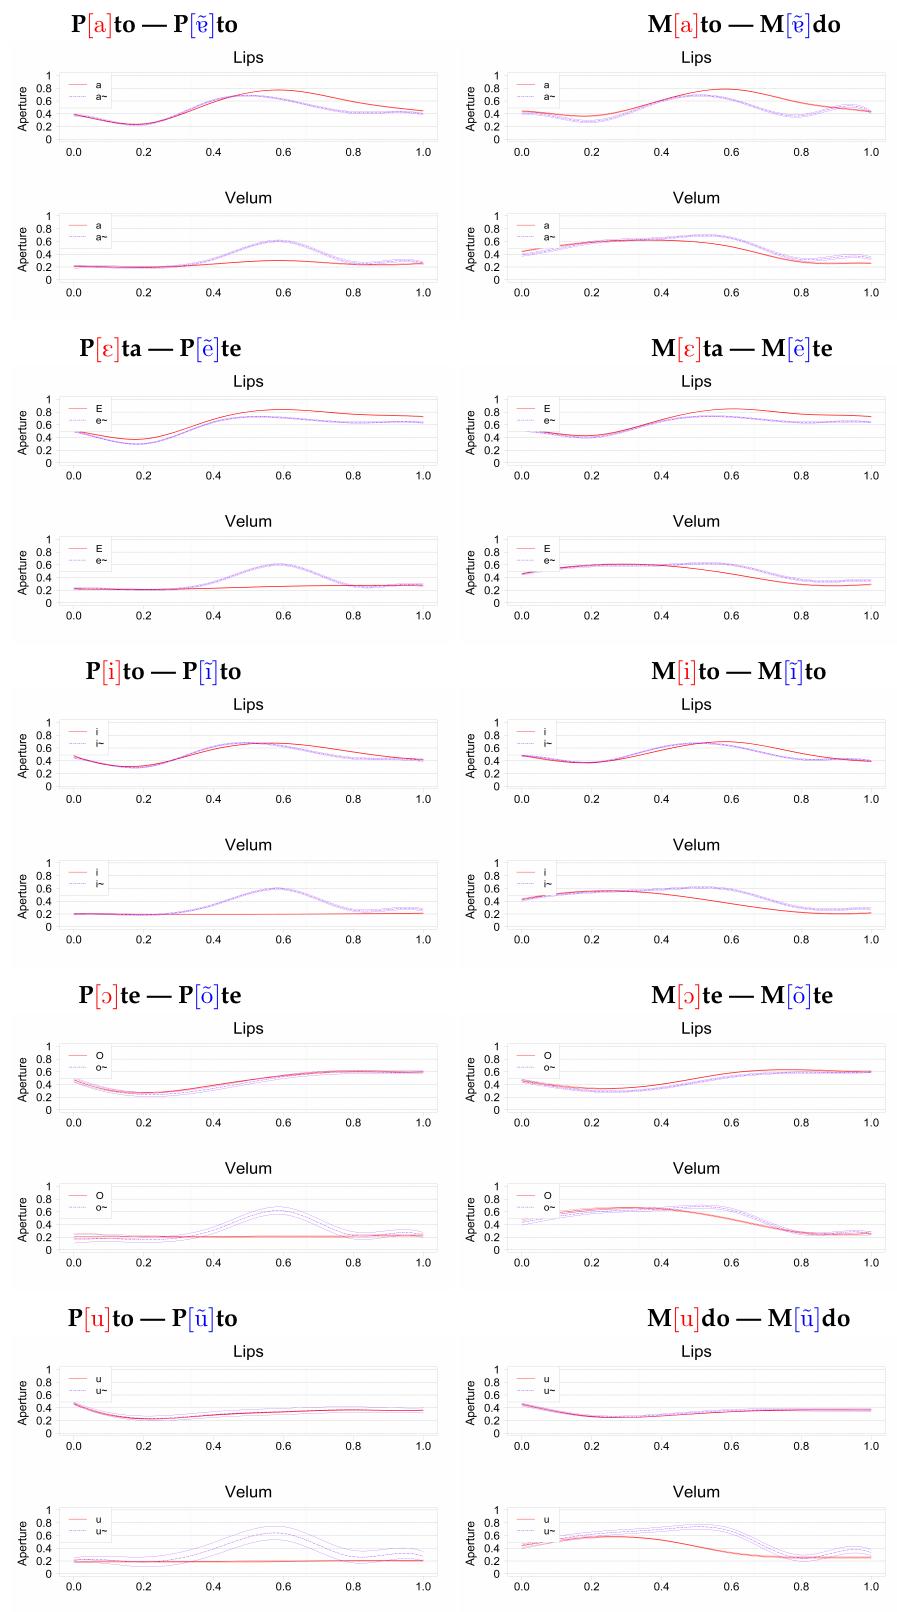
Figure 6. FLMMs of lip and velar aperture over time for the different vowels and contexts, obtained from articulatory data from 11 speakers. Curves for the oral vowels in red, and for the nasals in